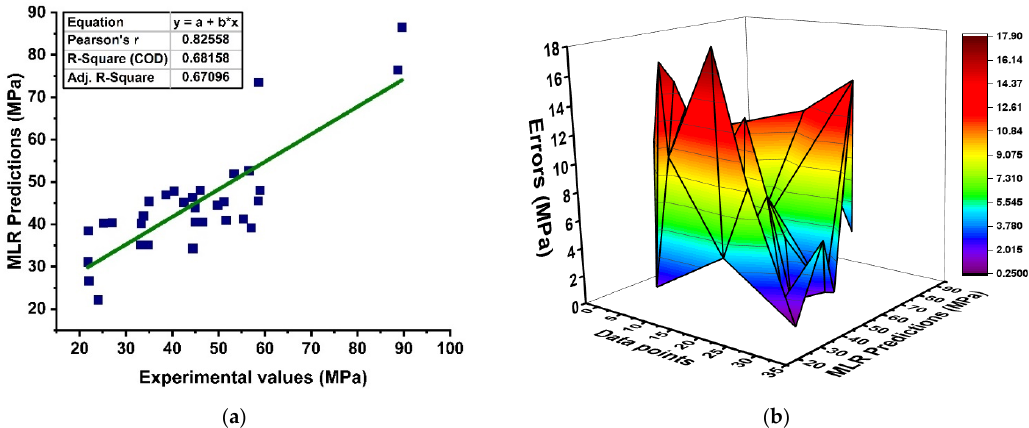
Figure 4. ( a ) Linear regression modeling; ( b ) distribution of errors via regression .